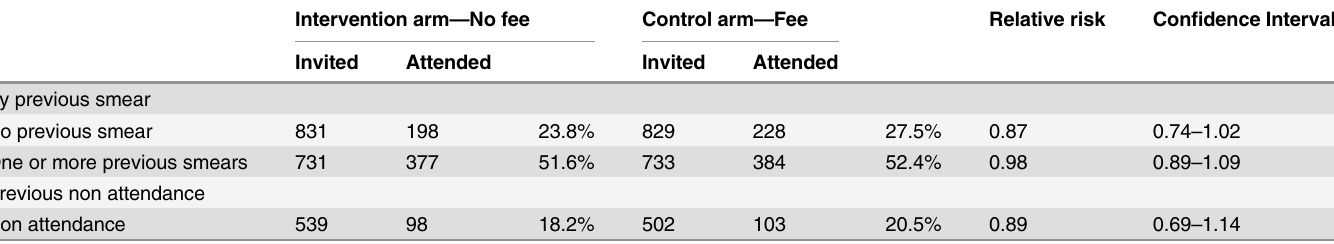
Table 2. Attendance in intervention and control arm stratified by previous history of registered smear and previous documented non-attendance. Intervention arm — No fee Control arm — Fee Relative risk Con fi dence Interval Invited Attended Invited